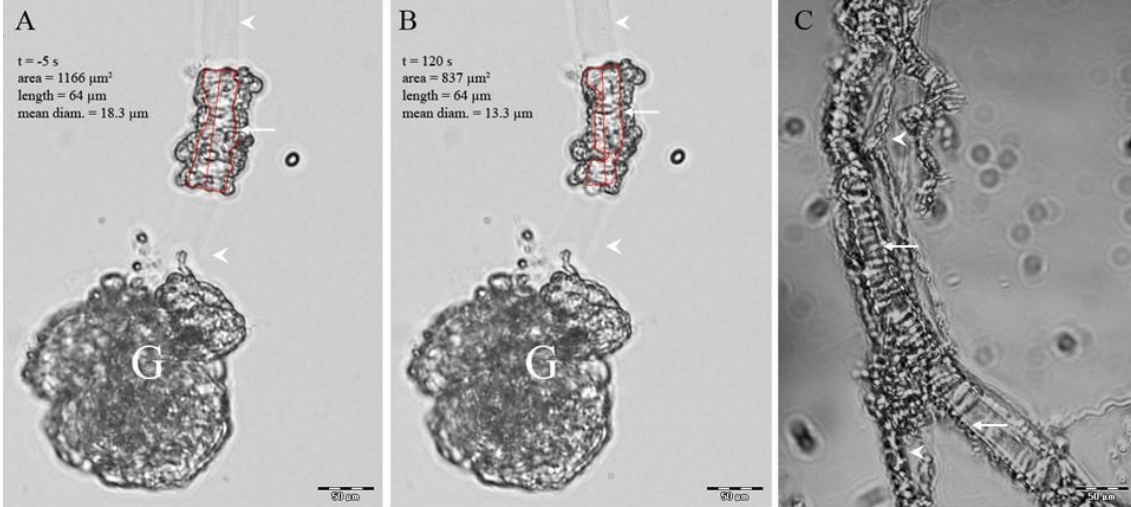
Figure A1. Representative tracing of wild-type afferent arteriole (AA) from mouse with intravascular agarose (arrow heads) isolated using the agarose-infusion/enzyme-treatment preparation ( A , B ). Red lines indicate the tracing of the lumen area and length, used to calculate mean lumen diameter.